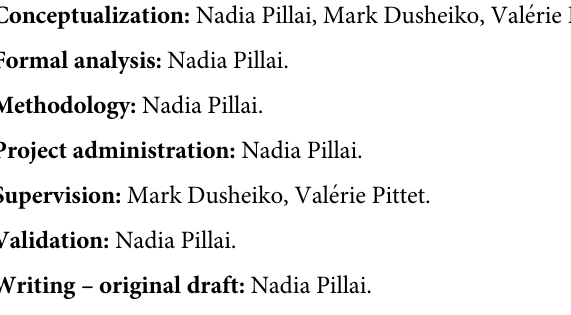
S1 Table. Full literature search. S2 Table. Descriptive information of included studies. S3 Table. Results of the risk of bias assessment. S4 Table. PRISMA